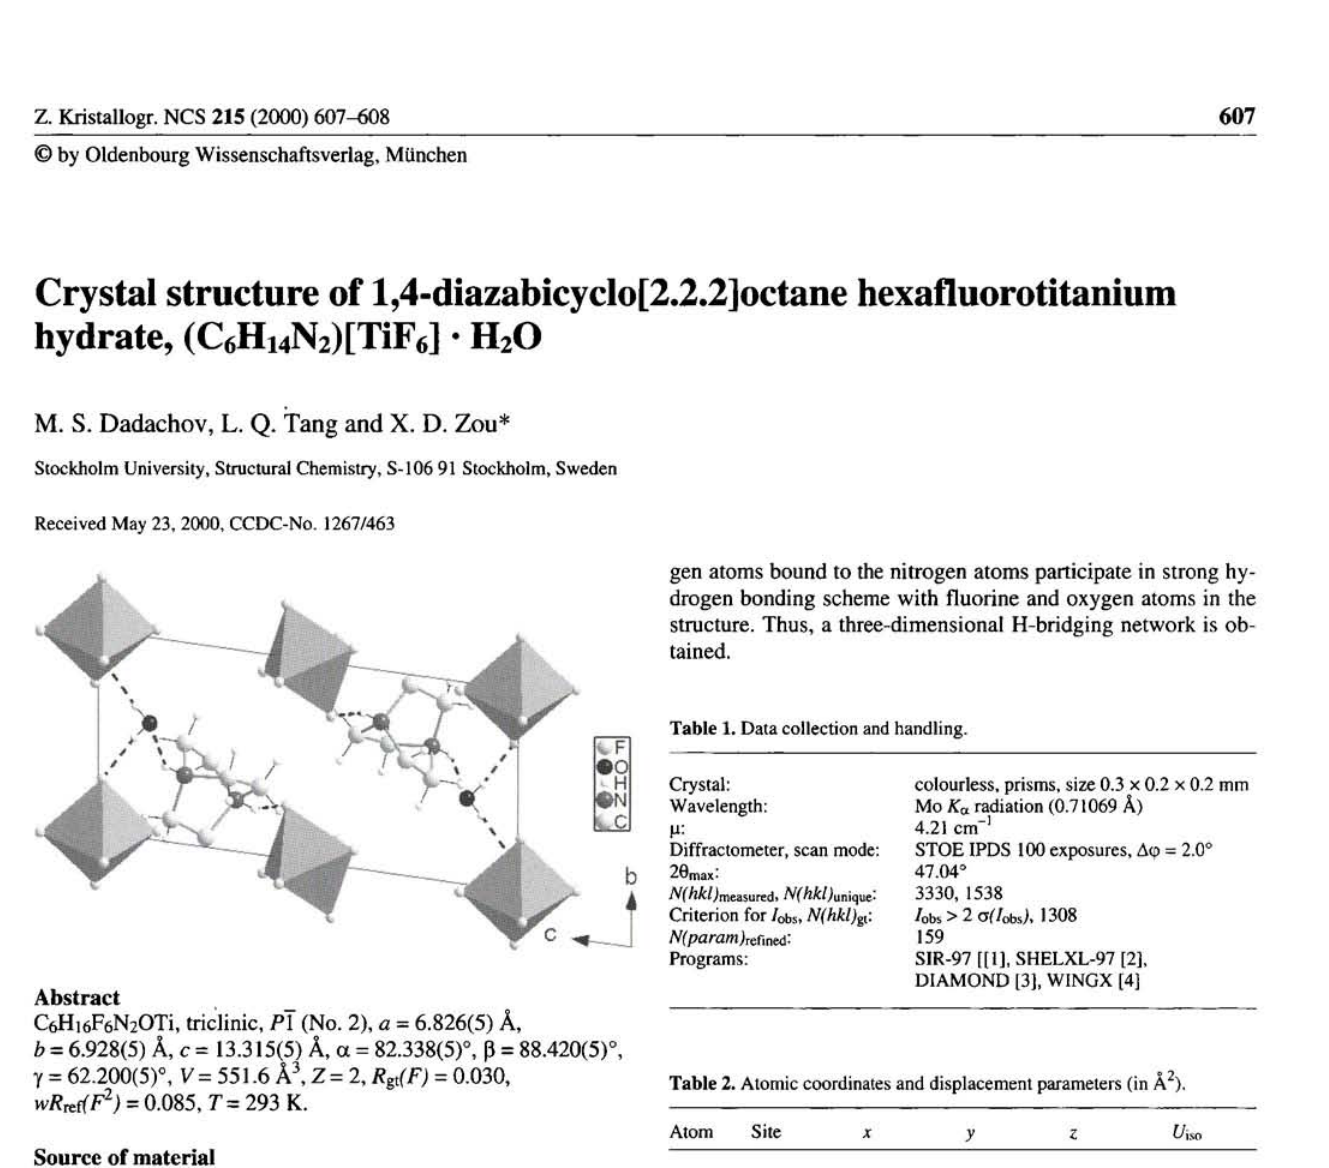
Table 2. Atomic coordinates and displacement parameters (in A